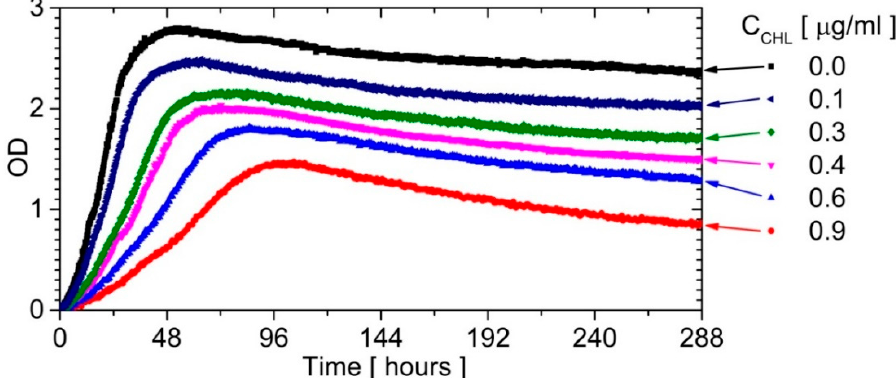
Figure 5. The bacterial growth curves for a long-term incubation inside a droplet for different concentrations of chloramphenicol (CHL).